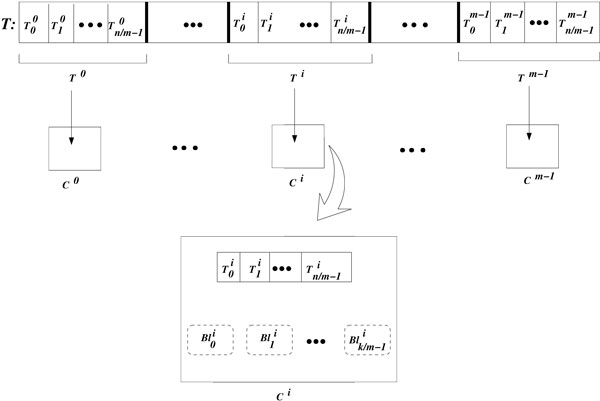
Multi-GPU Algorithm. An arrow Ti→ Ciindicates that the supersegment Tiis copied to the global memory of GPU Ci; Tji denotes the segment j belonging to supersegment i; Blji denotes the block Bljstarted in Ci.